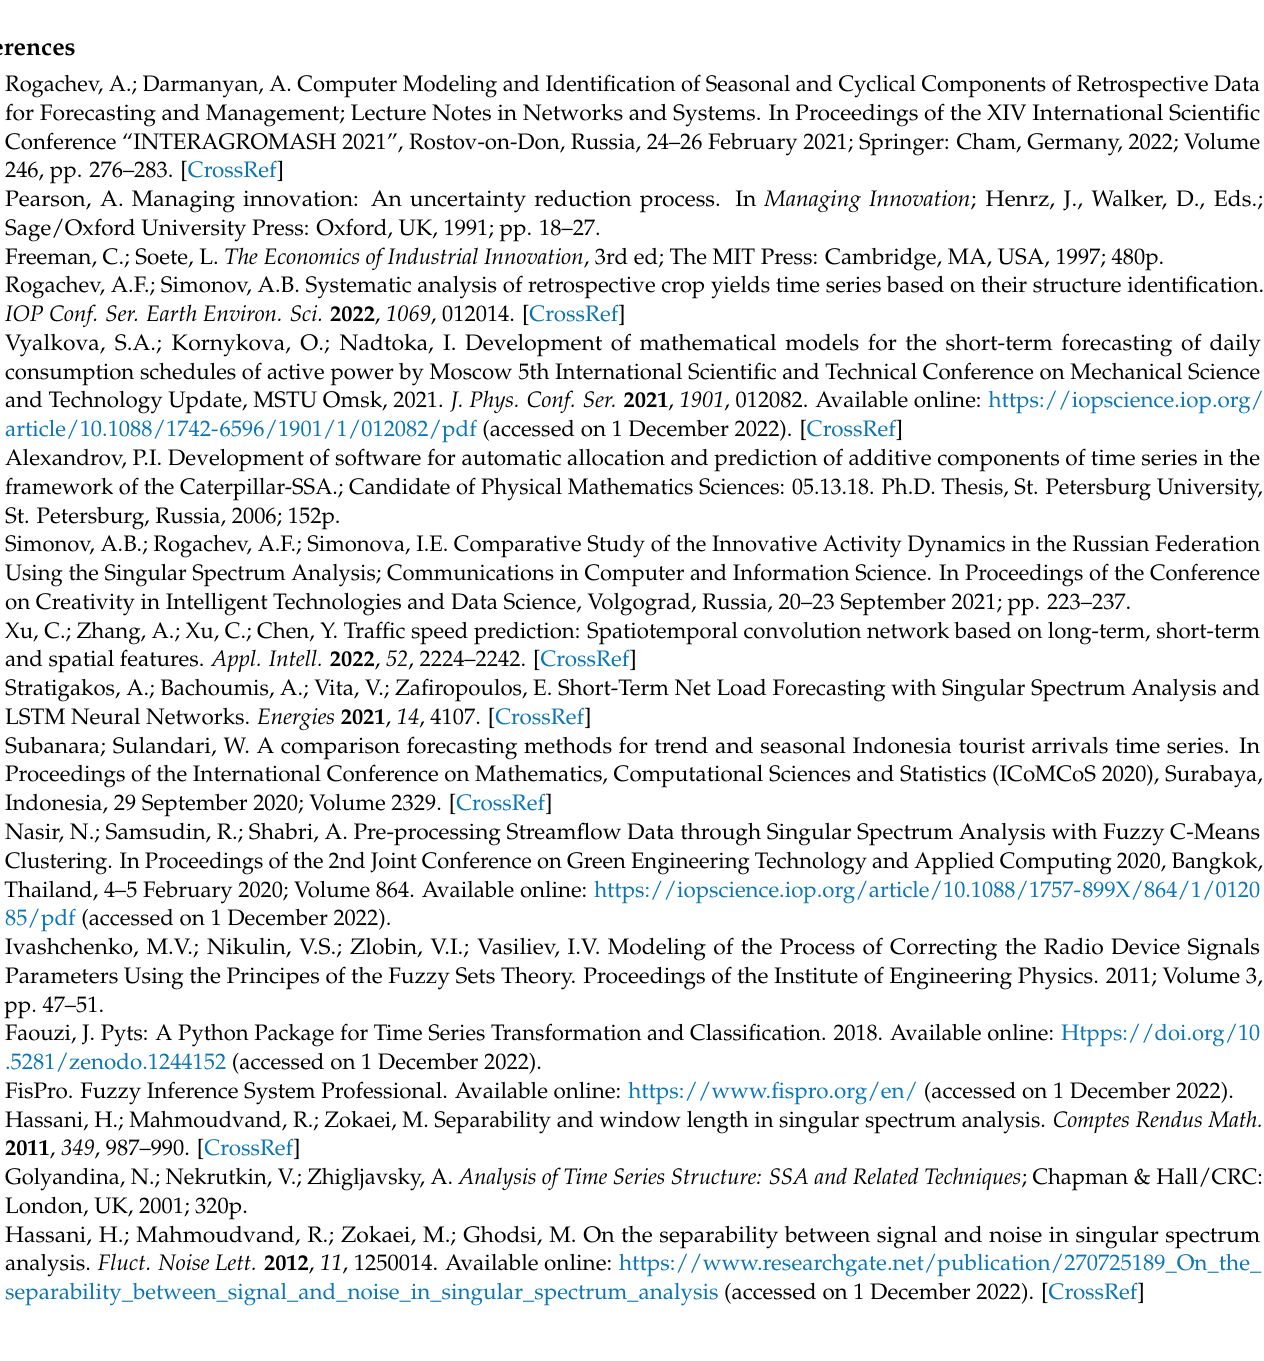
Table_S7.csv, Table_S8.csv, Table_S9.csv: Results of components (C1–C6) of innovation activity dynamics in Russian Federation (%) recognition and modeling; Table_S10: Comparison of models of innovation activity dynamics in the Russian Federation